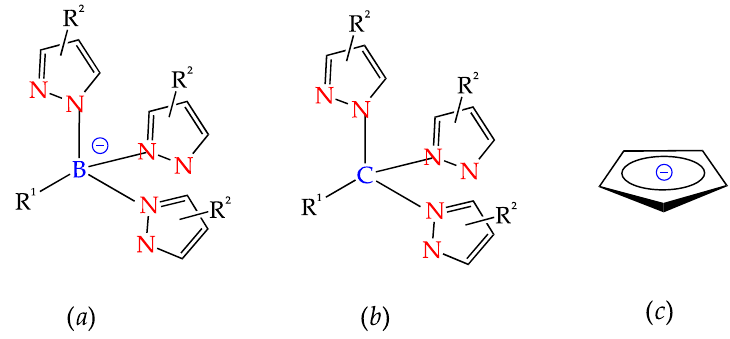
Figure 2. Structural general representation of tris(pyrazol-1-yl)borate ( a ); tris(pyrazol-1-yl)methane ( b ); and cyclopentadienyl ( c ) ligands.